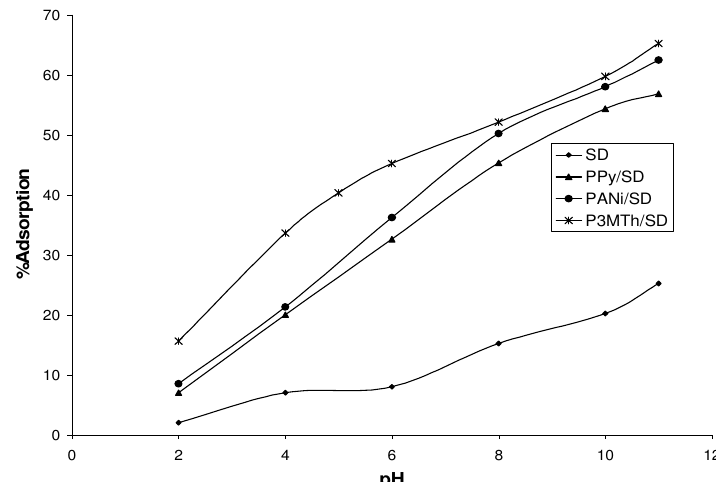
Figure 4 . The effect of pH on As(III) sorption by SD, PPy/SD, PANi/SD and P3MTh/SD. Effect of initial concentration